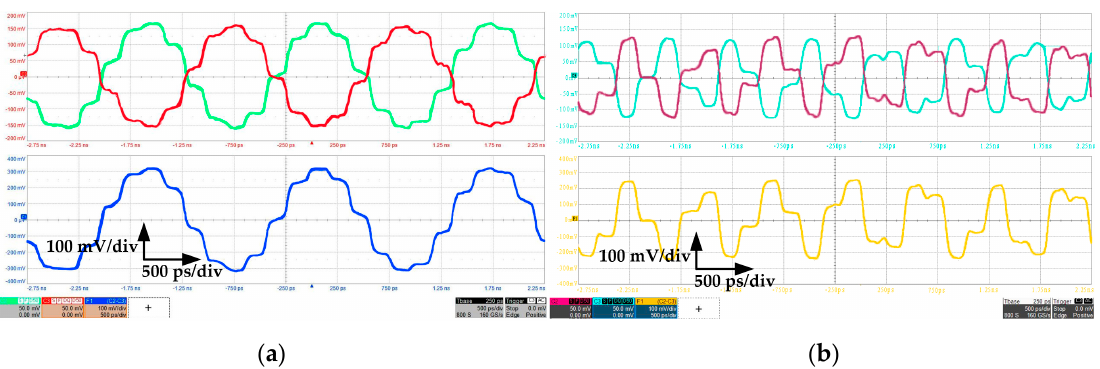
Figure 11. Time-domain measurement. The upper two waveforms are complementary single-ended outputs, and the bottom one is the differential output. ( a ) A 600 MHz input signal sampled by 5 GS/s; ( b ) a 13.6 GHz input signal sampled by 5 GS/s.